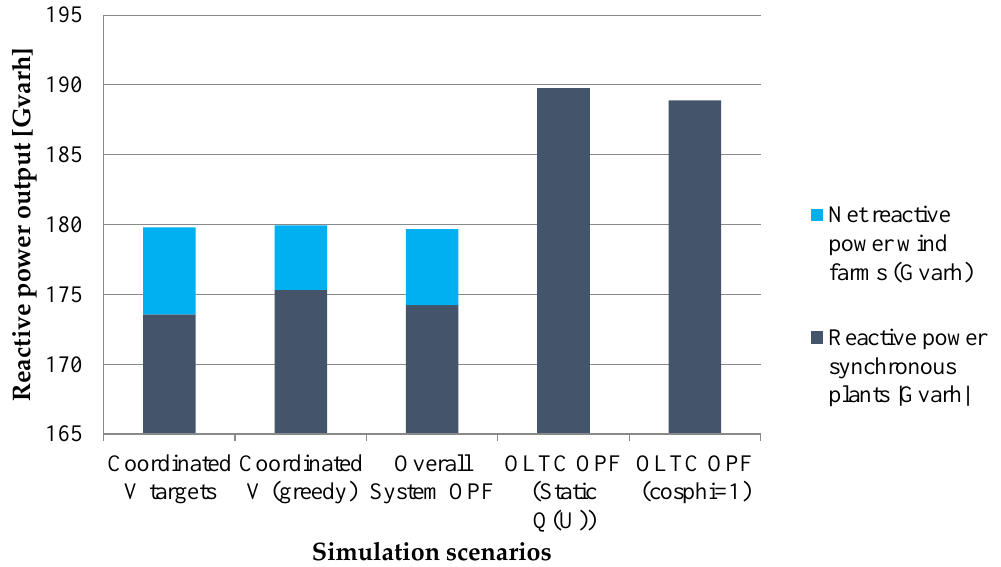
Figure 20. Reactive power output from 110 kV wind farms and transmission connected synchronous generators in the different scenarios.